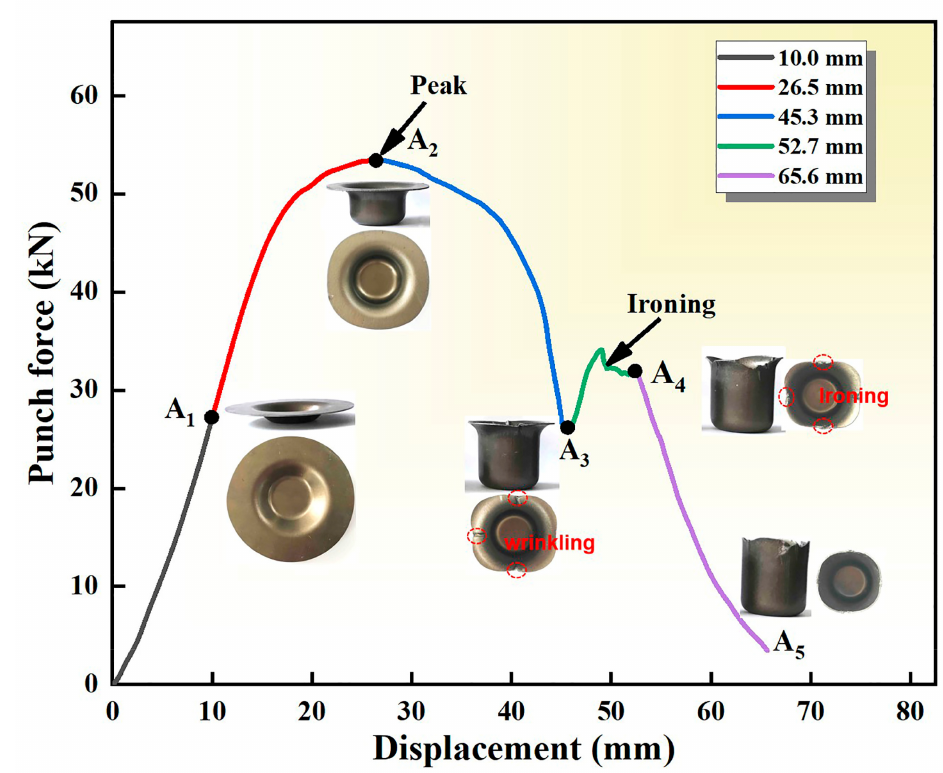
Figure 7. The deep-drawing parts and punch-force-displacement curve of three-layers with the diameter of 95 mm recording the drawing stages of A 1 –A 5 . The punch force is gradually increased and then stabilized at the A 4 stage. The wrinkles generated in the flange edge are gradually pulled into the fixed and narrow gap between punch and cavity die, and the material flow is restricted by the gap size, which leads to serious positive pressure stress in the upper cylinder wall. Then the friction between the blank and the die increases sharply, thus the punch force required to overcome the frictional resistance increases, and the second peak is formed in the punch-force-distance